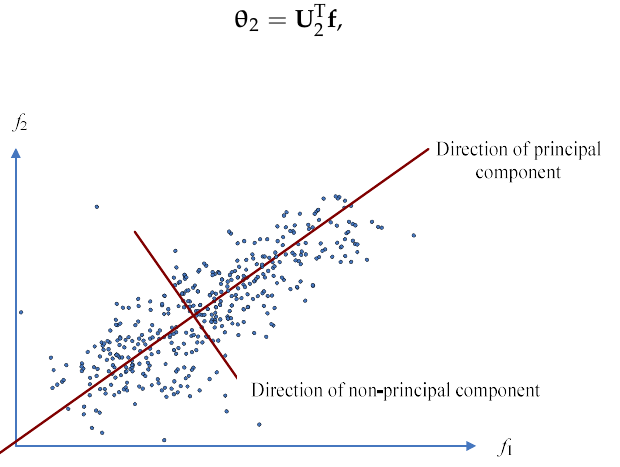
Figure 1. Schematic diagram of the PCA-based method with a two-dimensional example.